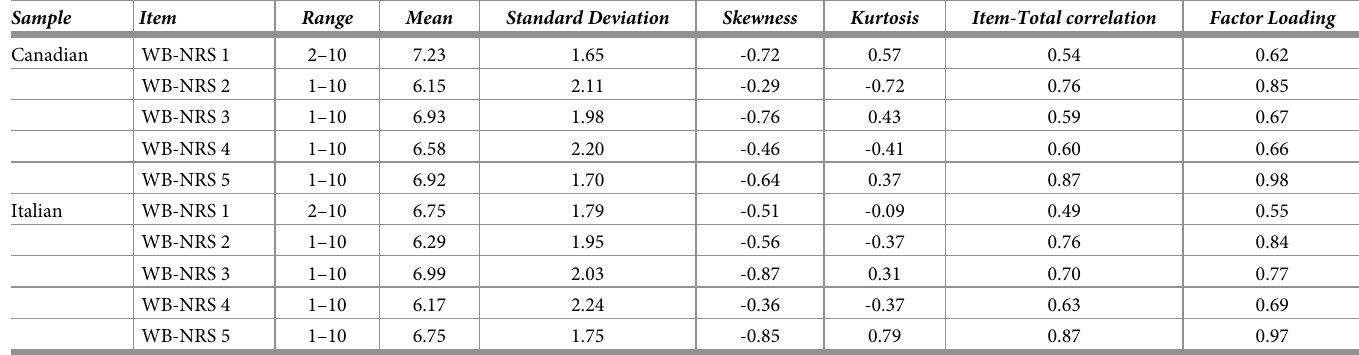
Table 6. Descriptives, item-total correlations (with item deleted), and factor loadings of the Well-being Numerical Rating Scales (WB-NRSs) in the Canadian and Italian samples. Sample